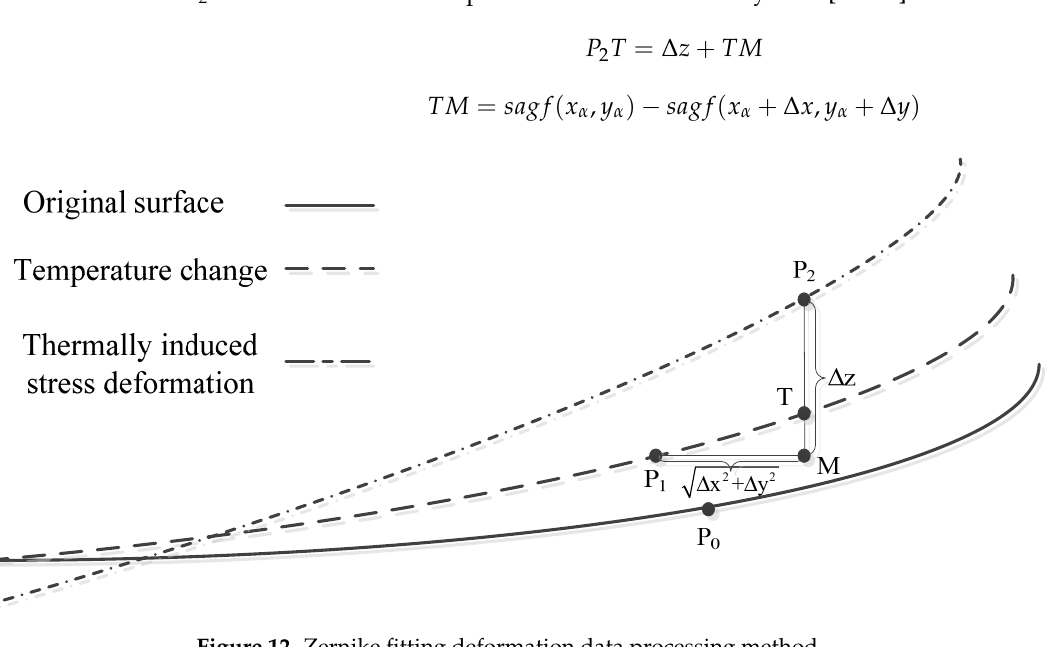
Figure 12. Zernike fitting deformation data processing method.